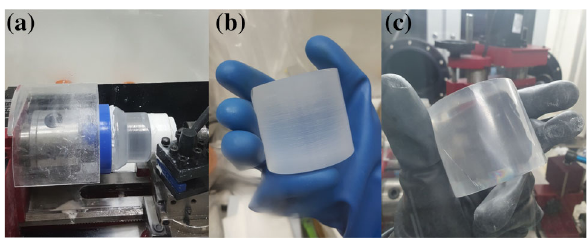
Fig. 4 NaI-035 crystal machining and polishing. a The crystal is machined into a cylindrical form using a lathe. The finished product before ( b ) and after ( c ) the surface polishing is shown